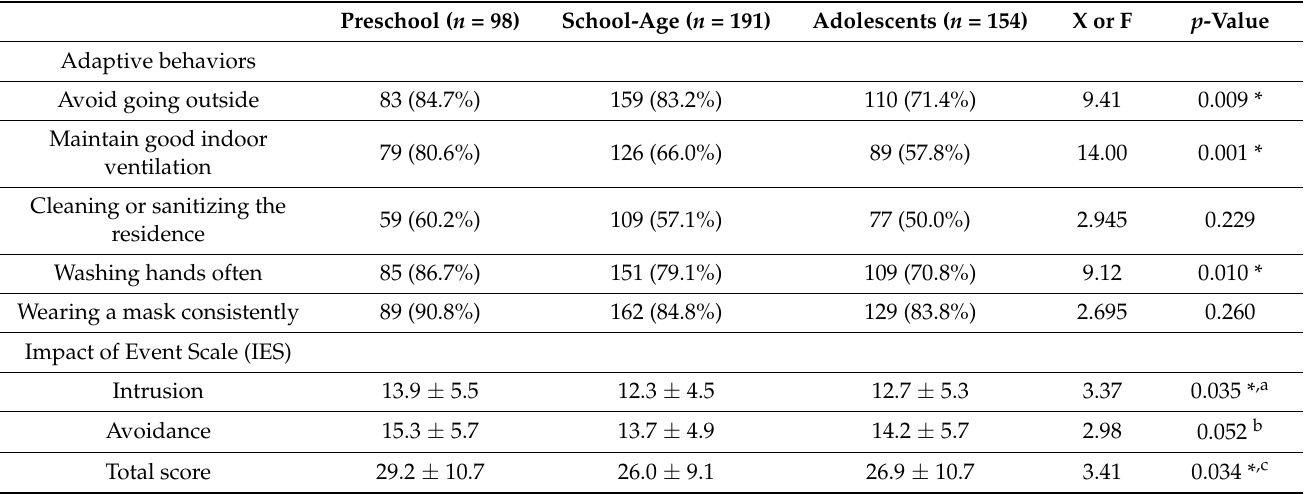
givers of preschool, school-aged and adolescents